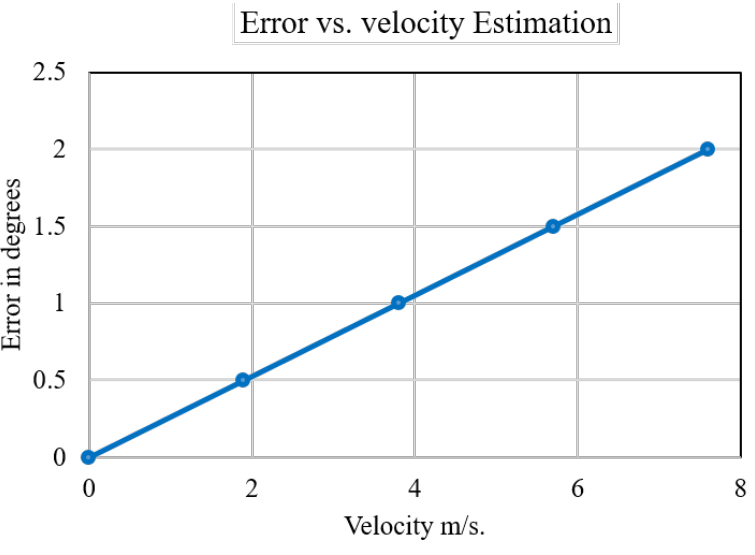
Figure 6. Representation of the analysis of the influence of the speed variation vs. error in degrees.